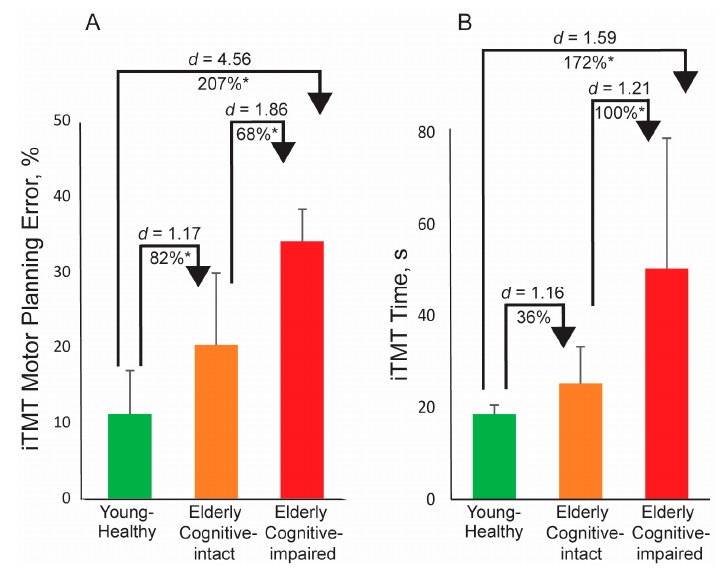
Figure 3. The iTMT derived parameters for all groups, including young-healthy group, elderly cognitive-intact group, and elderly cognitive-impaired group. ( A ) The iTMT MPE comparison; ( B ) the iTMT time comparison. Error bar represents the standard error. ‘*’ denotes when the pairwise group comparison achieved a statistically significant level ( p < 0.050). d denotes Cohen’s d effect size.